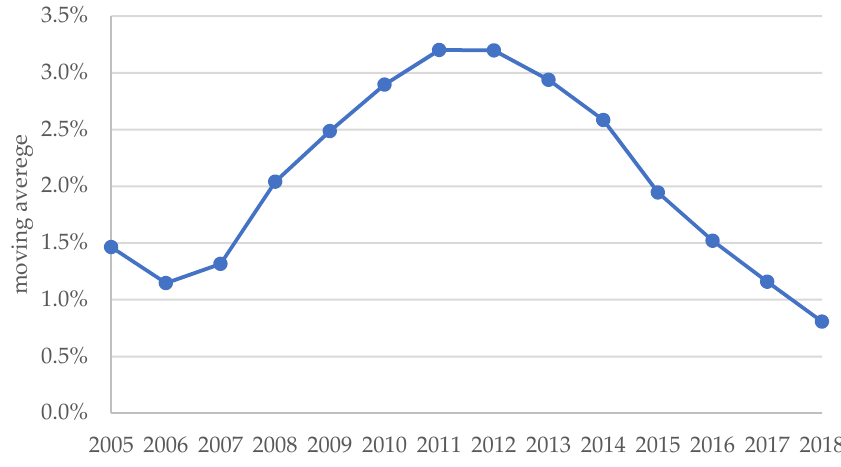
Figure 2. Moving average over a 15-year period of the annual growth of the house price index.